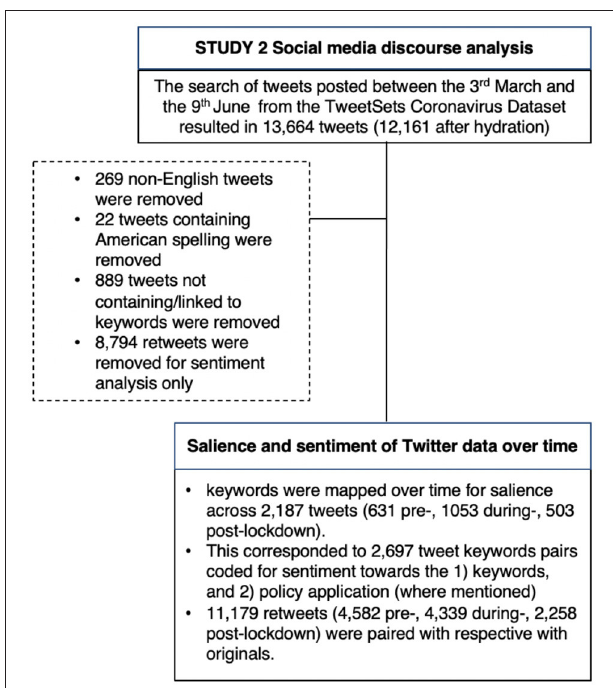
FIGURE 8 | Flowchart of data selection and cleaning process taken for Study